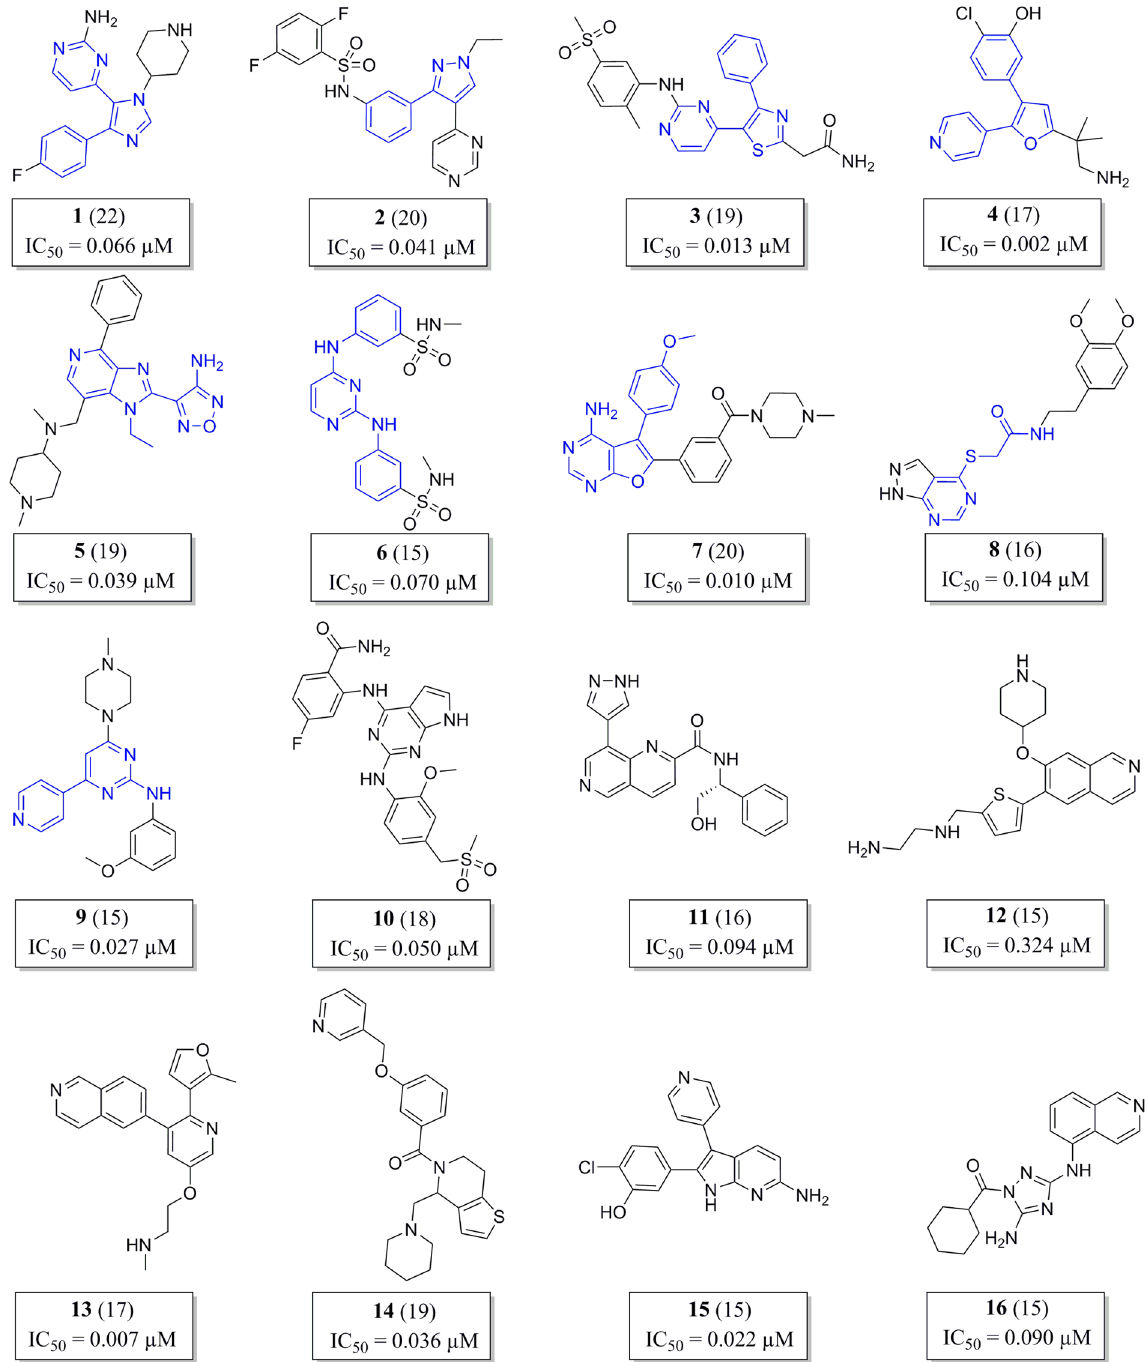
Figure 3. Prioritized compounds in their respective cluster class. Of the 66 prioritised compounds, the structure of the most scored compound in each cluster is shown, the common scaffold moiety across cluster representatives is coloured in blue. Each compound’s score is shown in parentheses and the IC 50 value corresponds with WT PfPKG